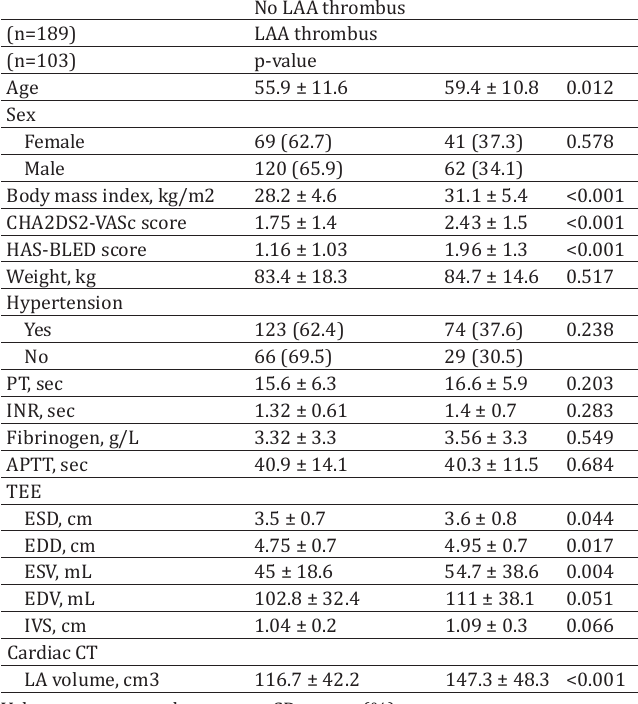
Demographic and medical characteristics of patients with and without LAA thrombus according to CT (N=292)